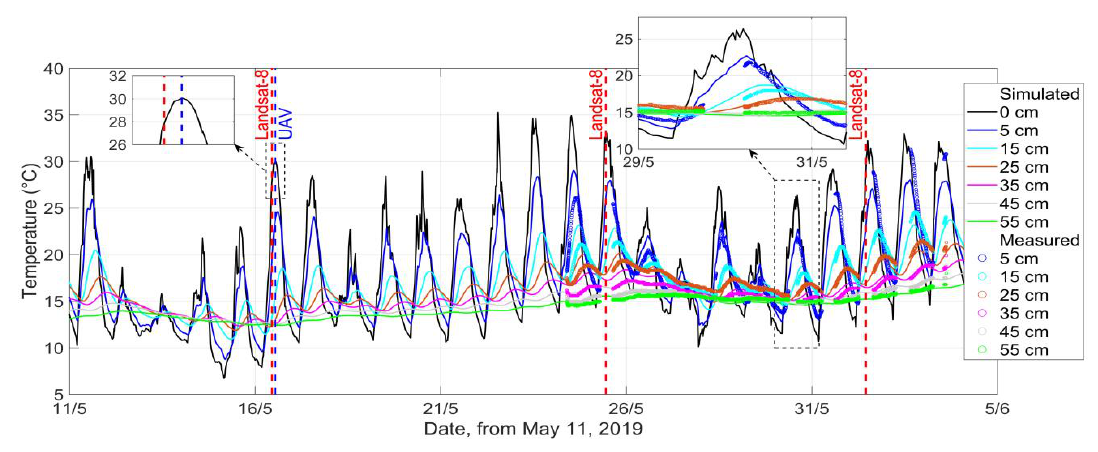
Figure 5. HYDRUS simulation of soil temperature based on meteorologic conditions compared with Sentek temperature measurements.